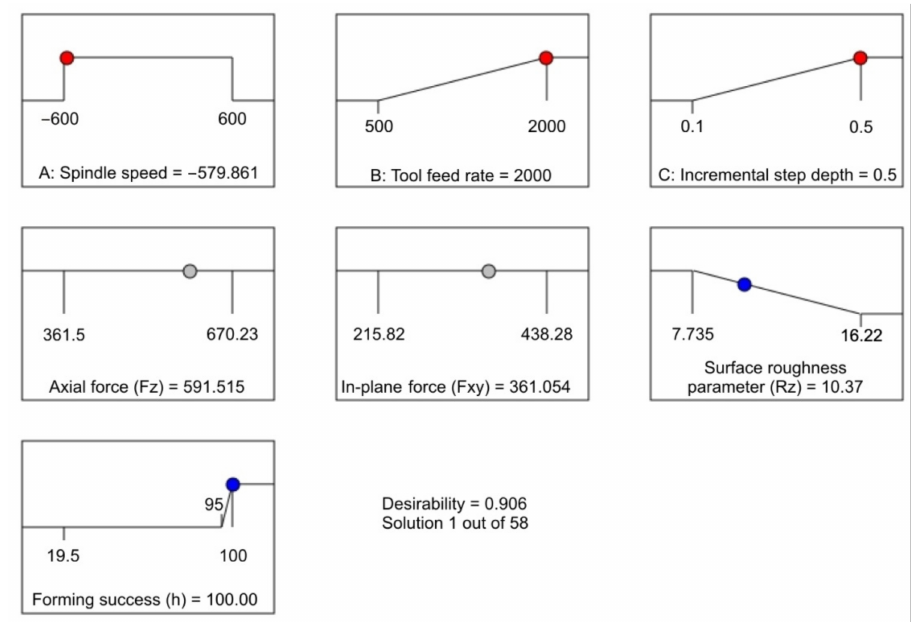
Figure 17. Ramp plot of optimisation